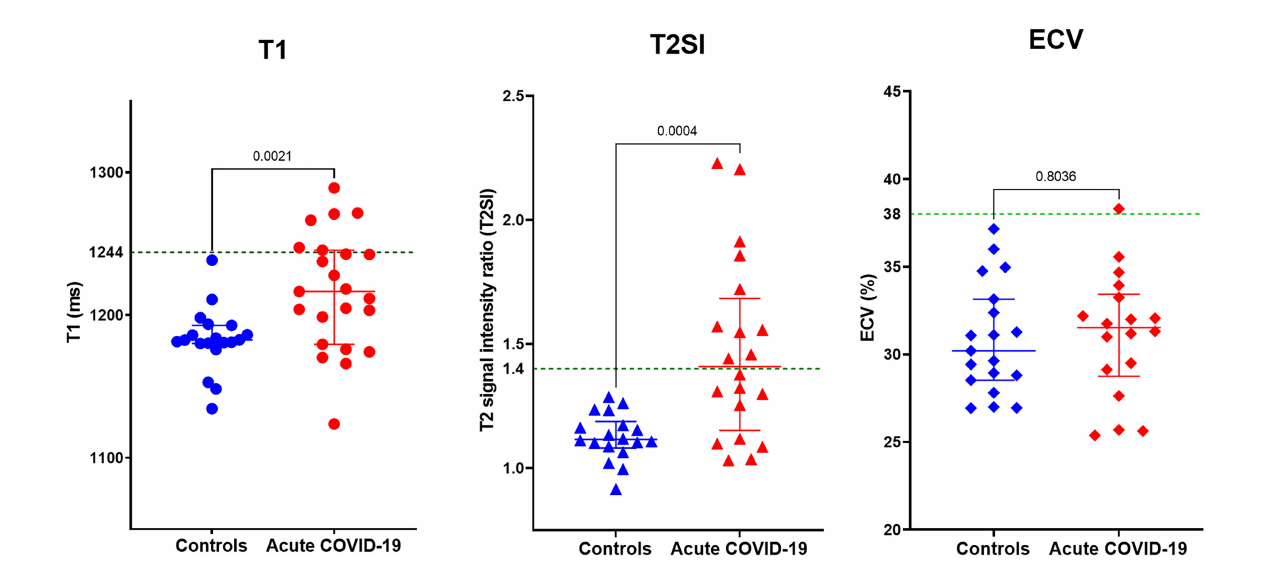
FIGURE 1 Myocardial tissue characteristics on cardiovascular magnetic resonance (CMR) during acute COVID-19 in hospitalized patients compared to controls without COVID-19 from the community matched for cardiovascular risk factors. Comparison of global myocardial T1, T2 signal intensity (T2SI) ratio, and extracellular volume (ECV) fraction between outpatient controls without COVID-19 and patients with acute COVID-19 during their hospitalization. Green dotted line in the graphs denotes the upper limit of normal ranges for T1, T2SI ratio, and ECV in the 3 T MR scanner used for this study.